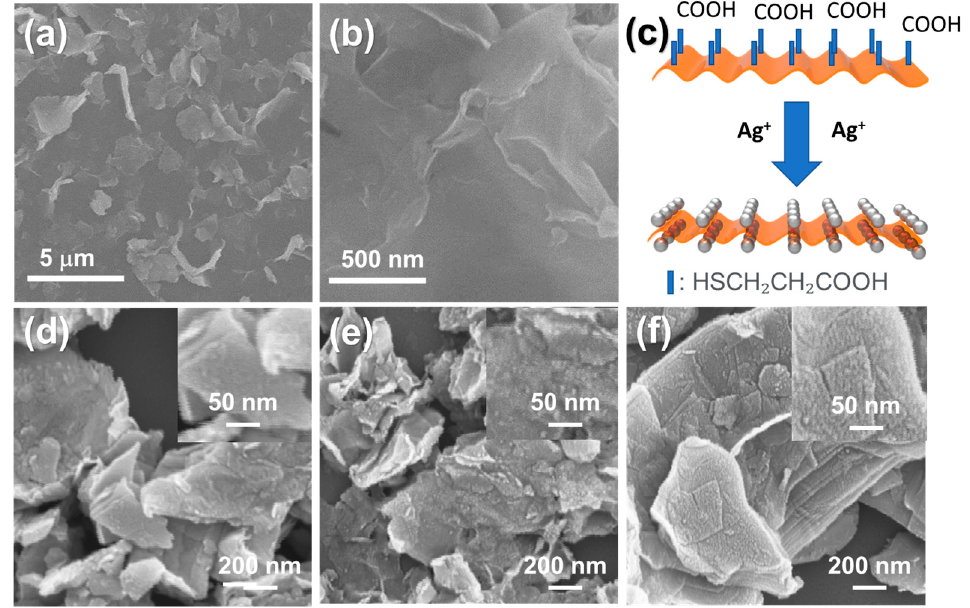
Figure 1. ( a , b ) Scanning electron microscopy (SEM) images of MoS 2 nanosheets (NSs); ( c ) illustra- tion of Ag-decorated MoS 2 NS; SEM images of ( d ) Ag1@MoS 2 , ( e ) Ag2@MoS 2 , and ( f ) Ag3@MoS 2 NS; SEM images of ( d ) Ag1@MoS 2 , ( e ) Ag2@MoS 2 , and ( f ) Ag3@MoS 2 NSs.